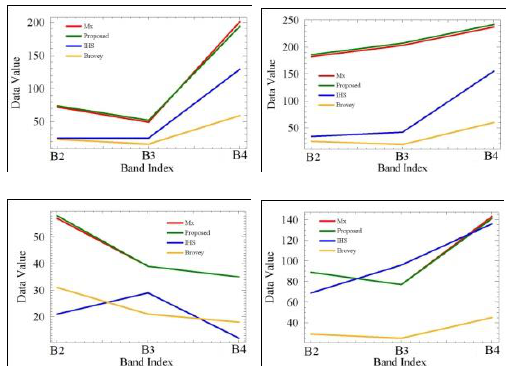
Figure 6: Fusion results of Kudala sangama,Karnataka